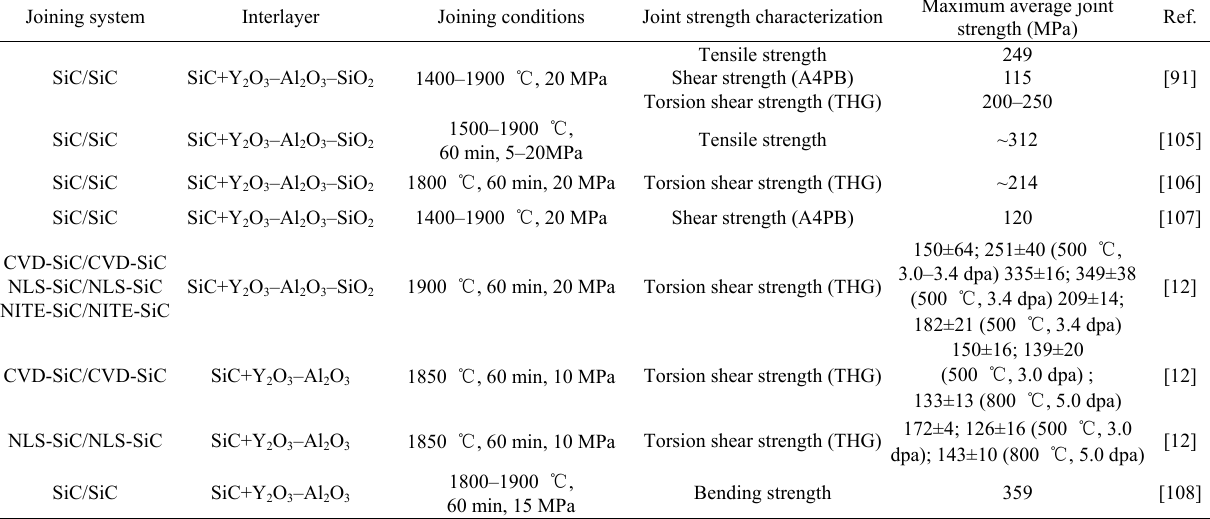
Table 7 Joining of SiC-based components using glass+ceramic as interlayer: interlayer, joining conditions, and joint strength